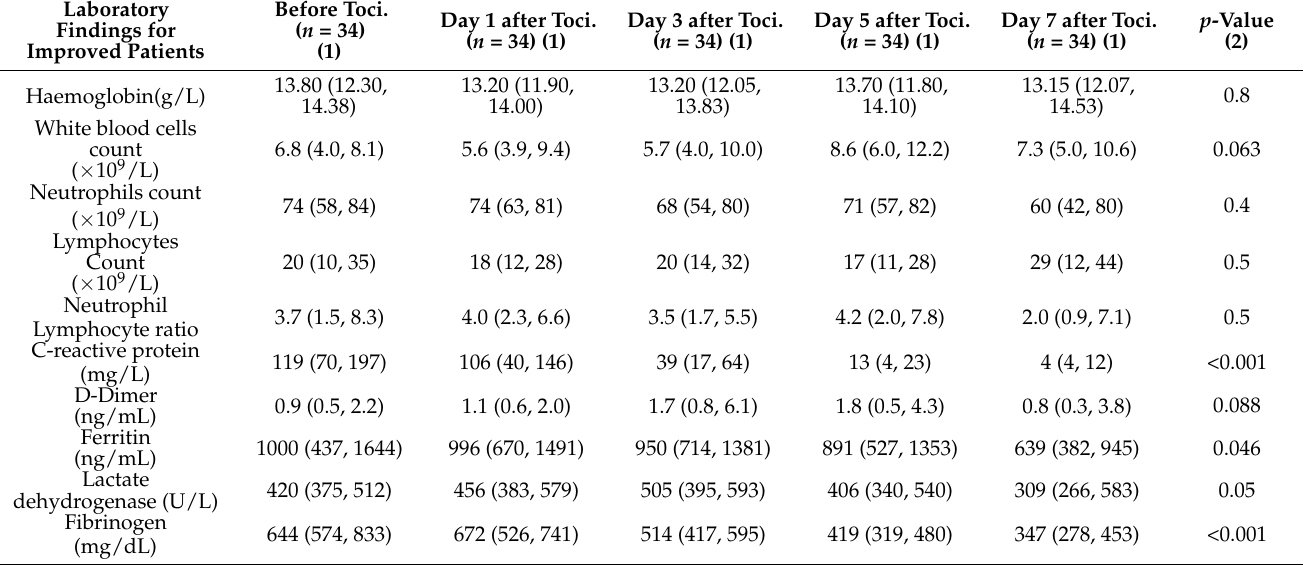
Table 4. Laboratory findings before and during Tocilizumab therapy among improved